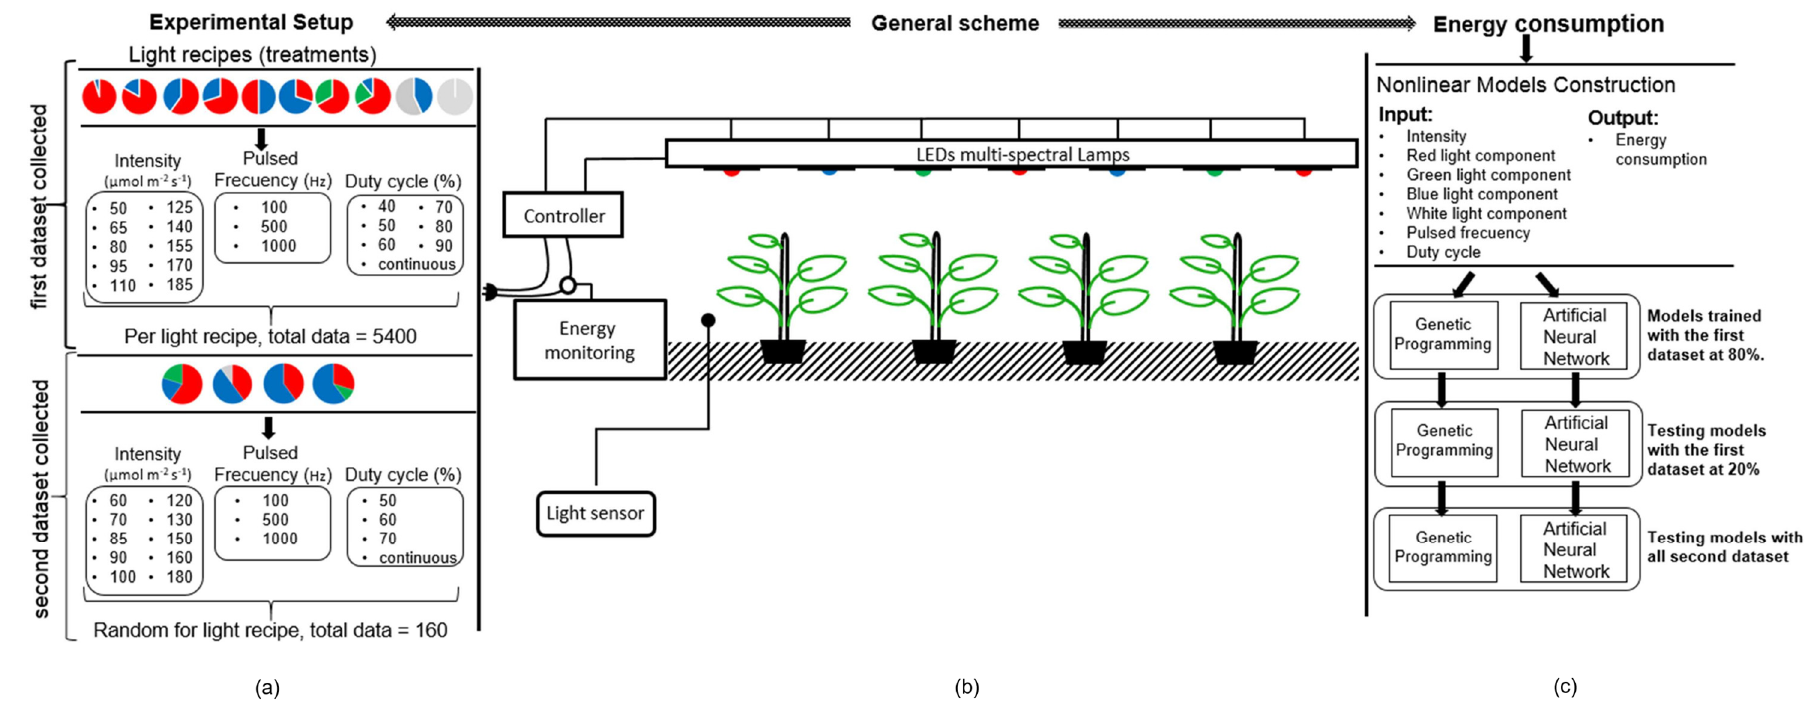
Figure 1. General experimental design. ( a ) Experimental setup for the two datasets. ( b ) Measuring general scheme. ( c ) Energy consumption nonlinear models construc-